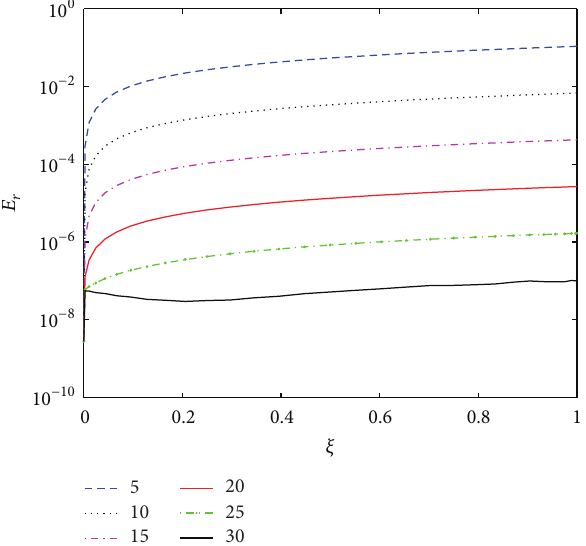
Figure 2: Residual error against 𝜉 for 𝑀 = 5, 10, 15, 20, 25, 30 when ℎ = −0.5